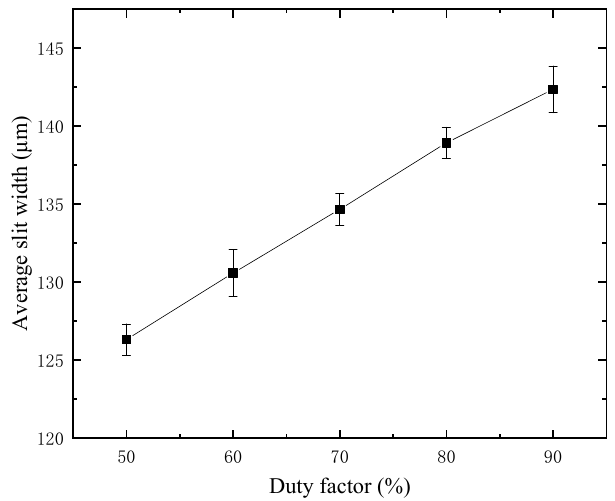
Figure 11. Slit width under different duty factors.